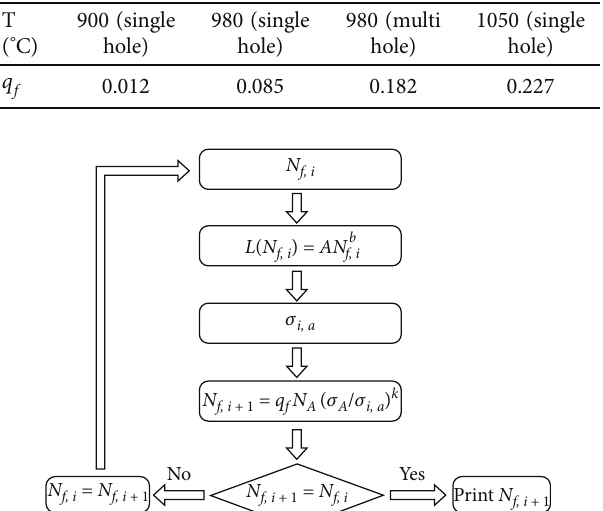
Table 1: Notch sensitivity coe ffi cient under di ff erent conditions.